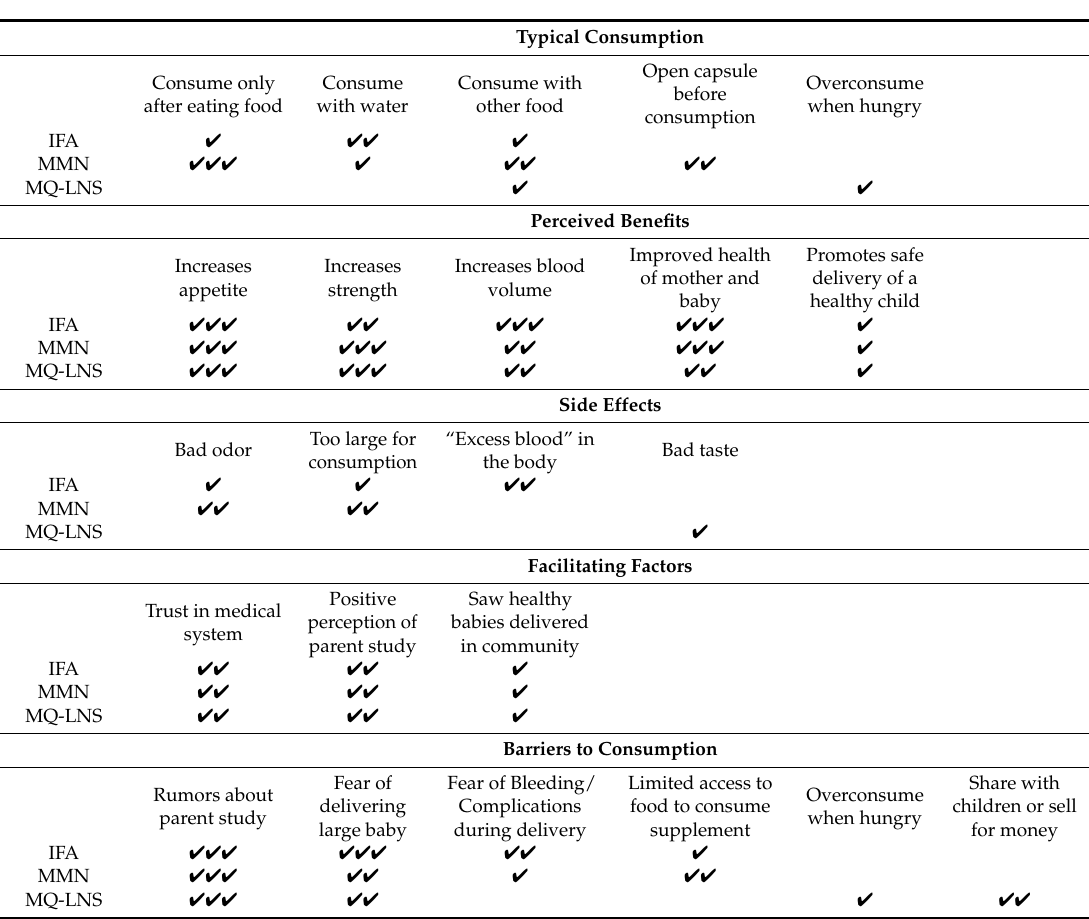
Table 2. Summary of main themes from qualitative